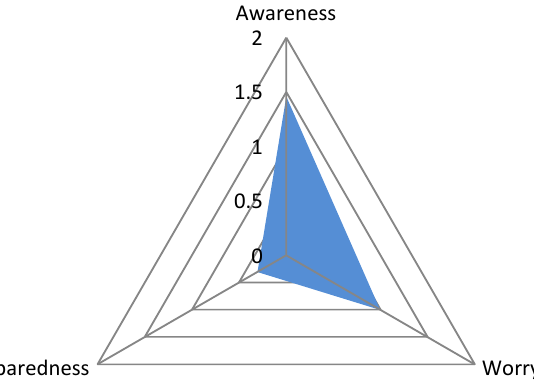
Fig. 3. Average scores for risk perception characteristics in Finland and Italy ( n = 529; non